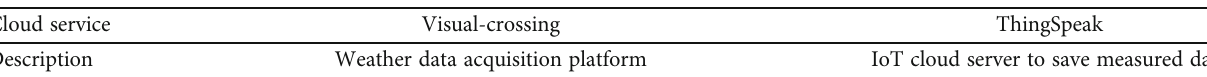
Figure 13: LR between power and temperature. Table 6: Essential cloud